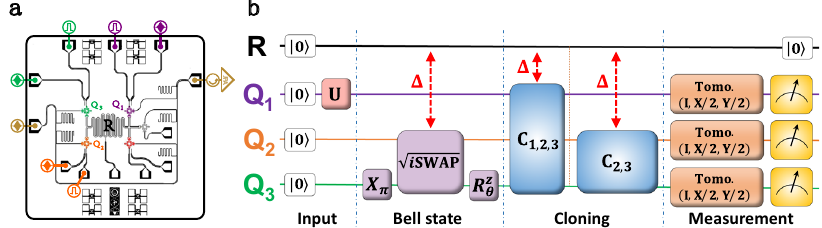
Fig. 1 Device image and experimental scheme for the implementation of UQCM. a The device image. The device sample has fi ve superconducting Xmon Qubits (three of them are used and are labeled from Q 1 to Q 3 ) and a central bus resonator R ; the qubits ’ manipulation and their coupling to the resonator and the measurement are controlled by microwave pulses injected onto the circuit sample. b Before the copying operation, all qubits are initialized to their ground state at the corresponding idle frequencies. The whole procedure can be divided into four steps: preparation of the input state through a unitary rotation at the idle frequency, denoted as U ; entanglement of Q 2 and Q 3 with ffiffiffiffiffiffiffiffiffiffiffiffiffiffiffi i SWAP Bell type, achieved by a π rotation X π on Q 3 , the Q 2 – Q 3